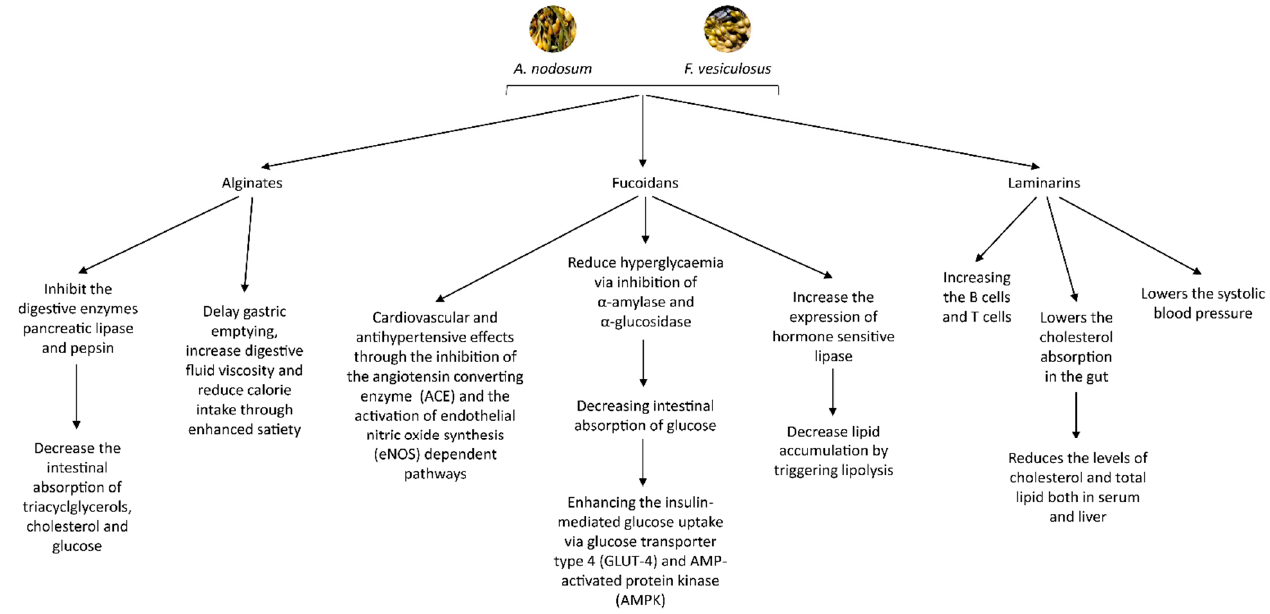
Figure 1. Summary of the molecules extracted from A. nodosum and F. vesiculosus in the management and progression of MetS.